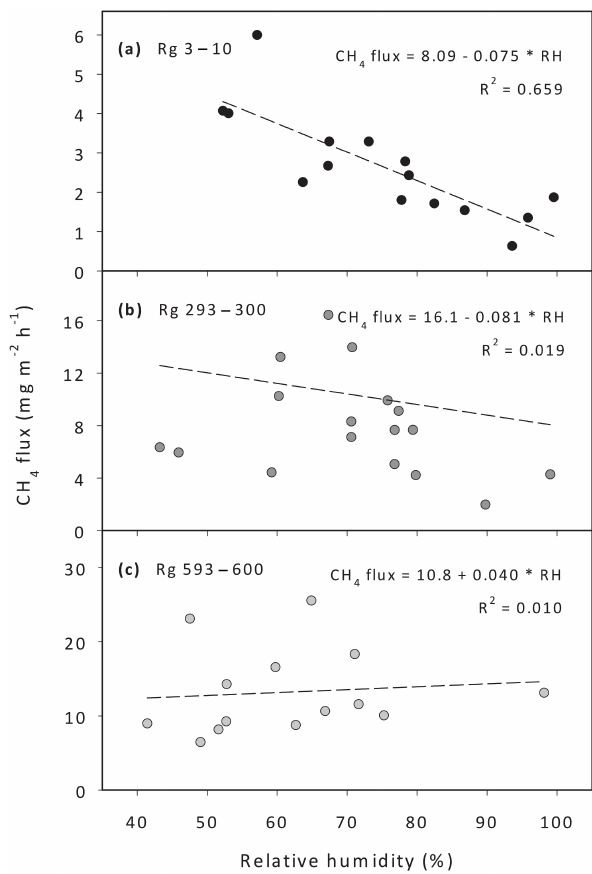
Figure 7. CH 4 flux plotted against relative humidity (RH). Data are selected by global radiation (Rg) in the range (a) 3–10, (b) 293– 300 and (c) 593–600Wm − 2 . Only data with a corresponding air temperature between 10–20 ◦ C are displayed.